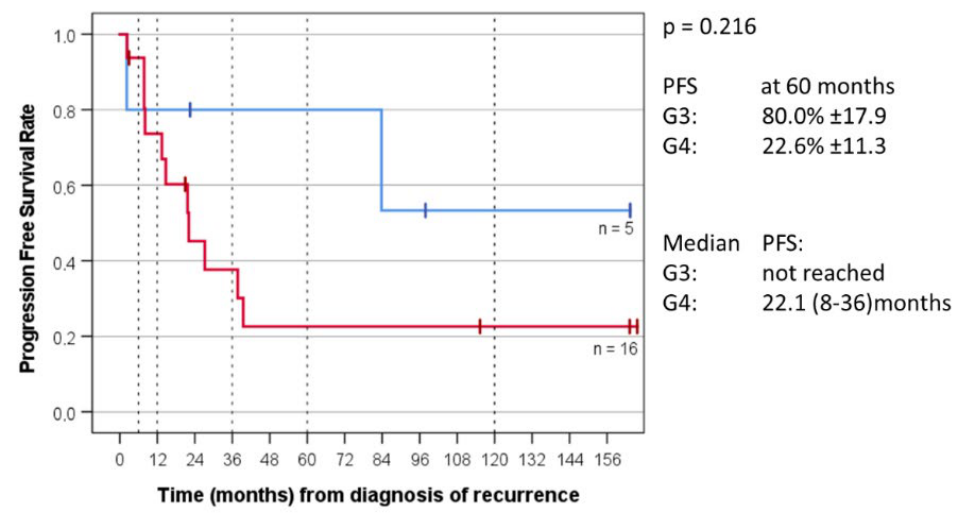
Figure 6. Event-free survival (EFS) of MB_G3 versus MB_G4 of 21 patients with recurrent non-WNT/ non-SHH medulloblastoma for which molecular group was known.